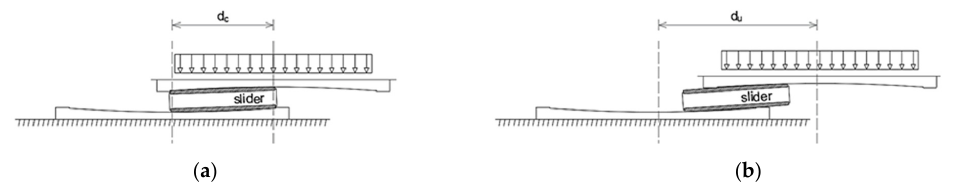
Figure 8. Maximum geometric ( a ) and ultimate ( b ) displacement of DCCSS Isolators. Table 4. Over-stroke parameters of the isolation system.